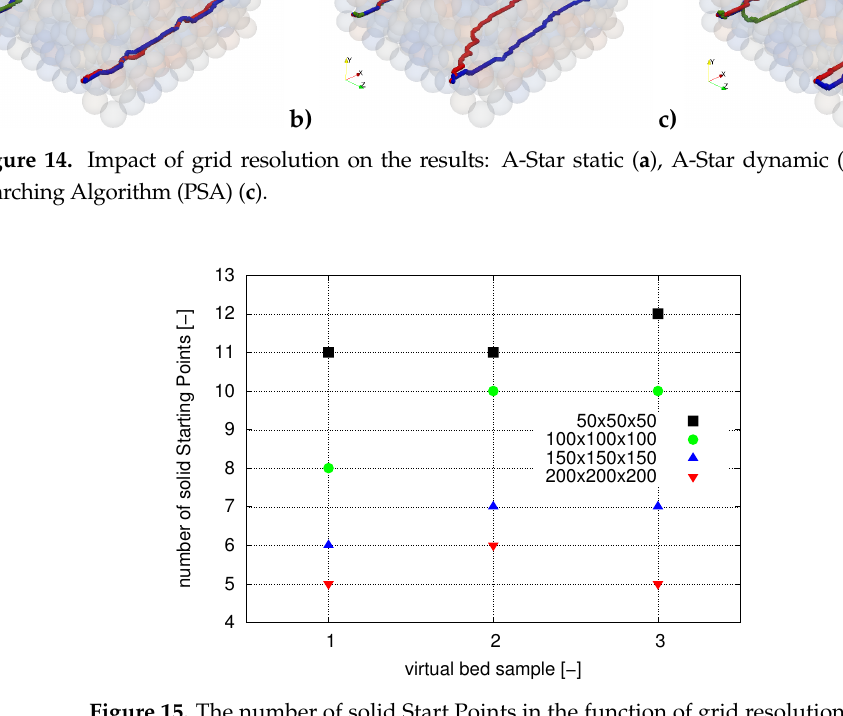
Figure 15. The number of solid Start Points in the function of grid